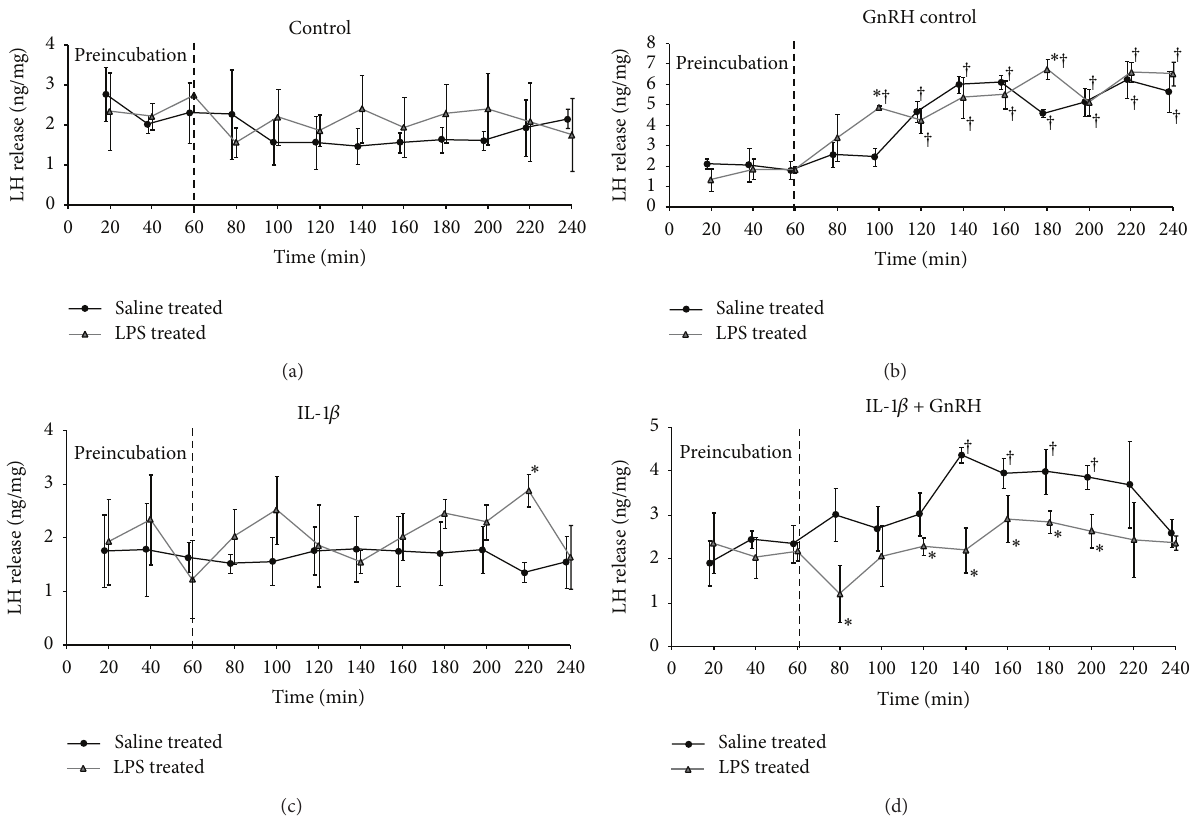
Figure 1: LH release from the AP explants collected from saline- and LPS- treated ewes and incubated in four types of media (control—“pure” medium 199 HEPES (a); GnRH control—medium with GnRH (100pmol/mL) (b); IL-1 𝛽 —medium with IL- 𝛽 (100pg/mL) (c); GnRH + IL-1 𝛽 medium with GnRH (100pmol/mL) and IL- 𝛽 (100pg/mL) (d)). Each curve represents median ± SEM release of LH during the consecutive 20 min periods of incubation. † 𝑃 ≤ 0.01 (cross indicates values that differ significantly from the median LH release in the same group during preincubation period according to the Mann-Whitney 𝑈 test) ∗ 𝑃 ≤ 0.01 (asterisk indicates values that differ significantly from the saline- treated group according to the Mann-Whitney 𝑈